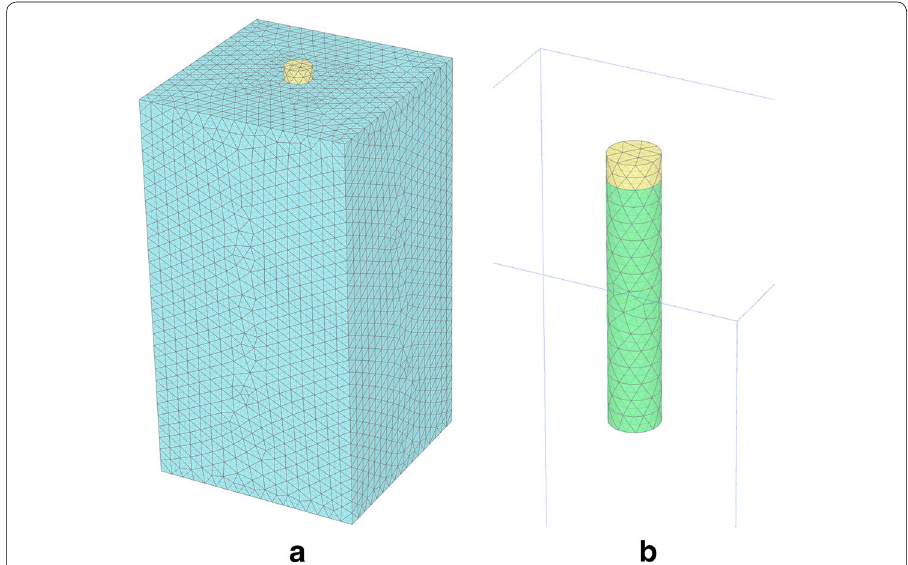
Fig. 1 a 3D numerical model; b stone column with rigid footing on top